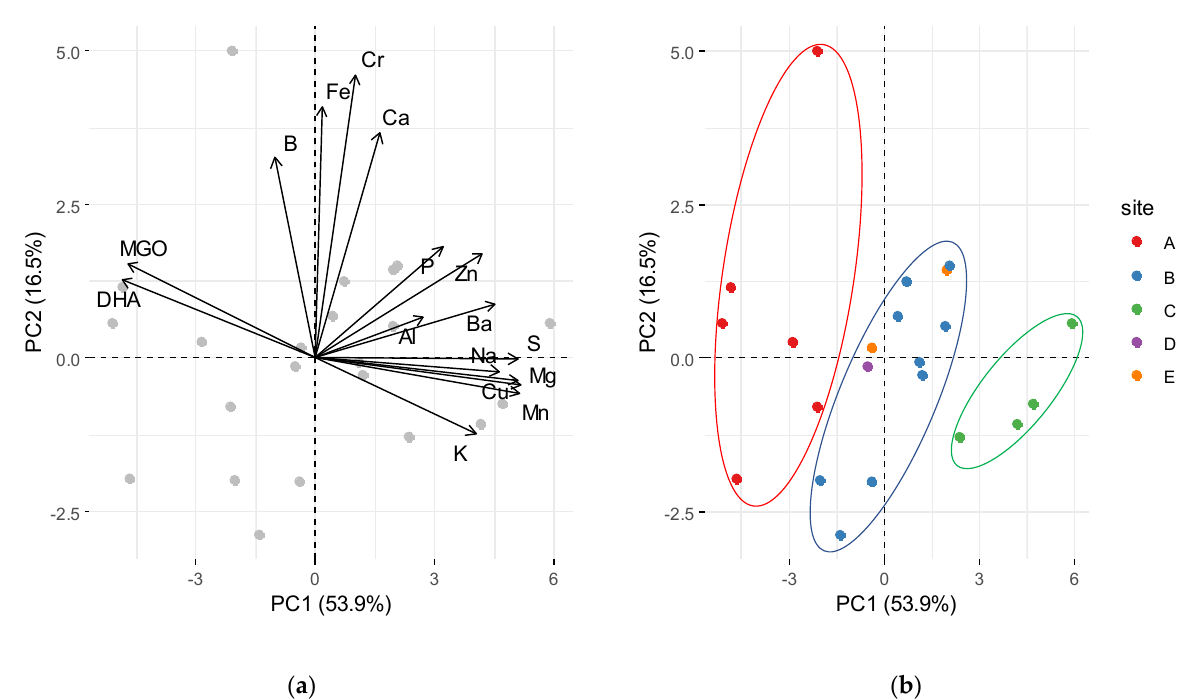
Figure 2. Principal component analysis (PCA) describing the variation of honey MGO, DHA, and elemental concentrations: ( a ) loading plot; ( b ) score plot. The ellipses are eye-guides to delineate the three distinct groupings.